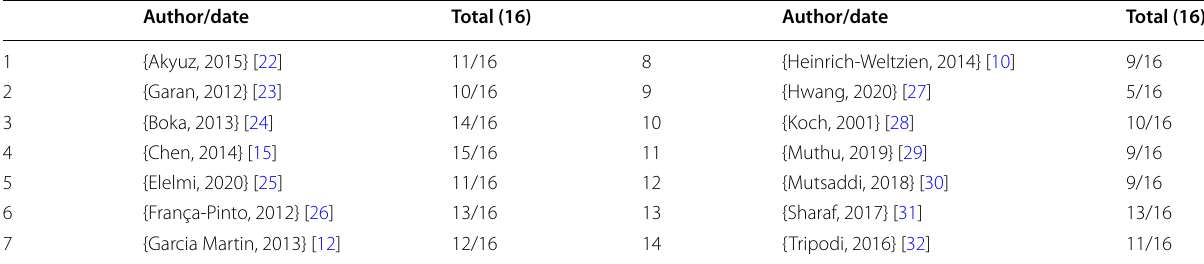
Table 3 Modified downs and black